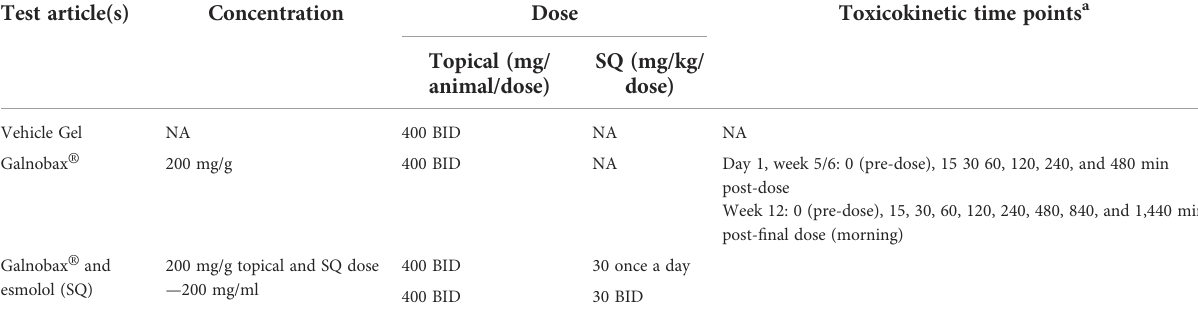
TABLE 1 Study design for long-term (12 weeks) toxicity in miniature